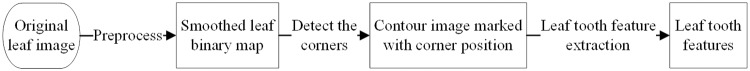
Block diagram of proposed framework for leaf tooth feature extraction.http://dx.doi.org/10.17504/protocols.io.wrxfd7n [PROTOCOL DOI].